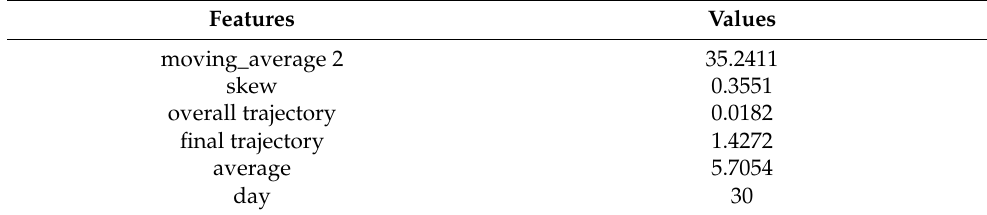
Table 11. Input Values for SHAP Force Plot 2.